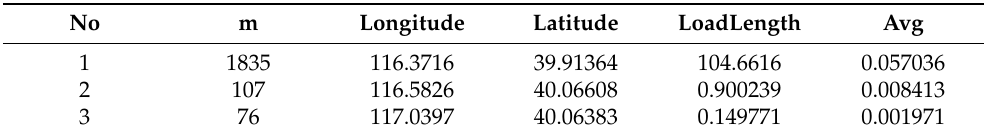
Table 16. The clustering results of PS_DBSCAN for the DS3